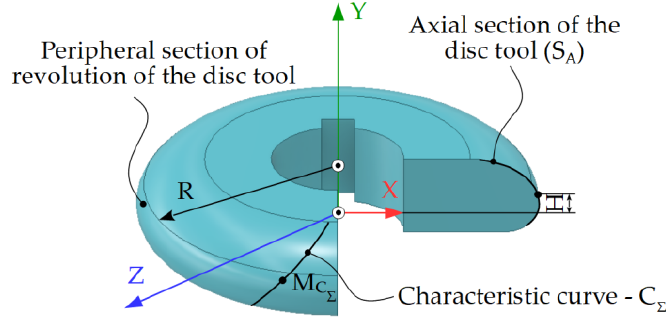
Figure 13. Axial section of the rotating surface [12]. The radius of the parallel circle is determined by the relation: